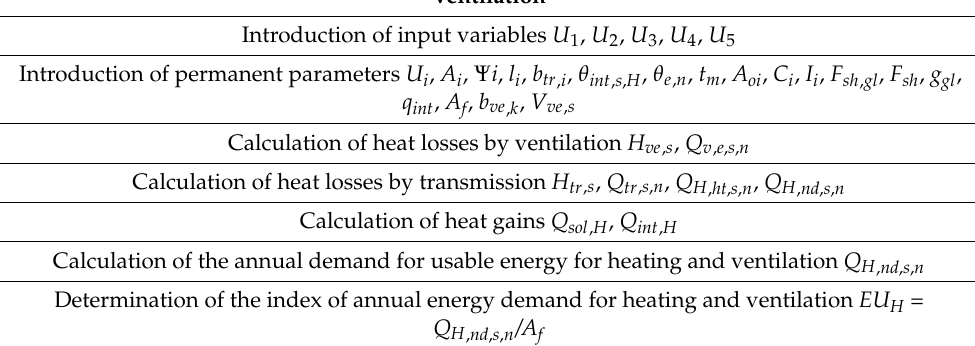
Table 3. Block diagram for calculating the index of annual usable energy demand for heating and ventilation of a selected building (kWh/(m 2 · year)) (own elaboration). Procedure for Calculating the Index of Annual Usable Energy Demand for Heating and